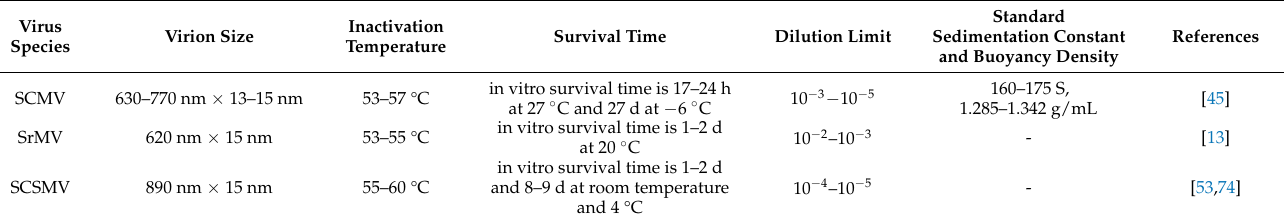
Table 1. Basic pathogenic characteristics of sugarcane mosaic